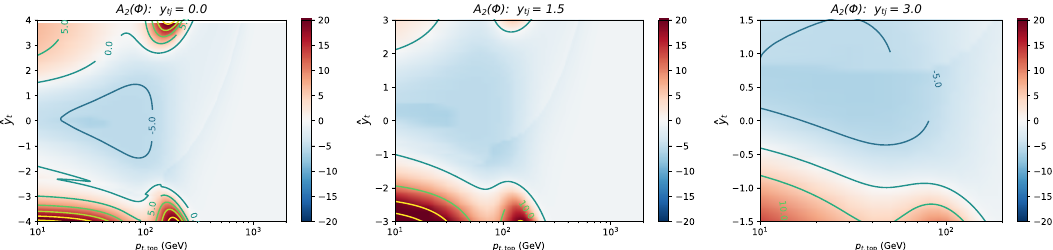
Figure 1 . Heatmap plots of the (cid:12)tted A 2 ((cid:8)) term in the Minlo Sudakov form factor, de(cid:12)ned through eqs. (2.9-2.11); used in promoting STJ ! STJ ? events by reweighting the former with the NNLL (cid:27) exponential factor, (cid:14) (cid:1)( y 12 ) (eq. (2.11)). The A 2 ((cid:8)) shown here has been obtained using the default (central) scale choices in the ST and STJ generators, for y tj = 0 : 0 (left plot), y tj = 1 : 5 (centre plot) and y tj = 3 : 0 (right plot). The ranges in each of the three plots vary in order to limit the amount of physically inaccessible phase space shown, while not cutting away any accessible